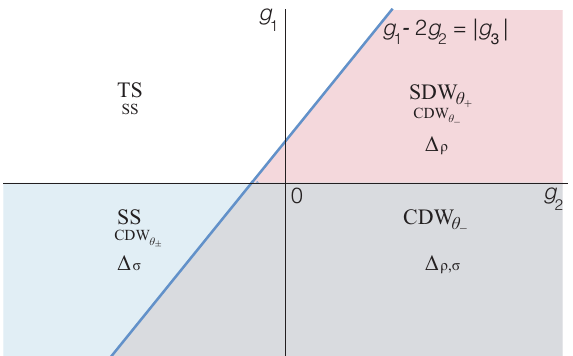
Figure 6. Phase diagram of the 1D alternated extended Hubbard model in the continuum electron gas